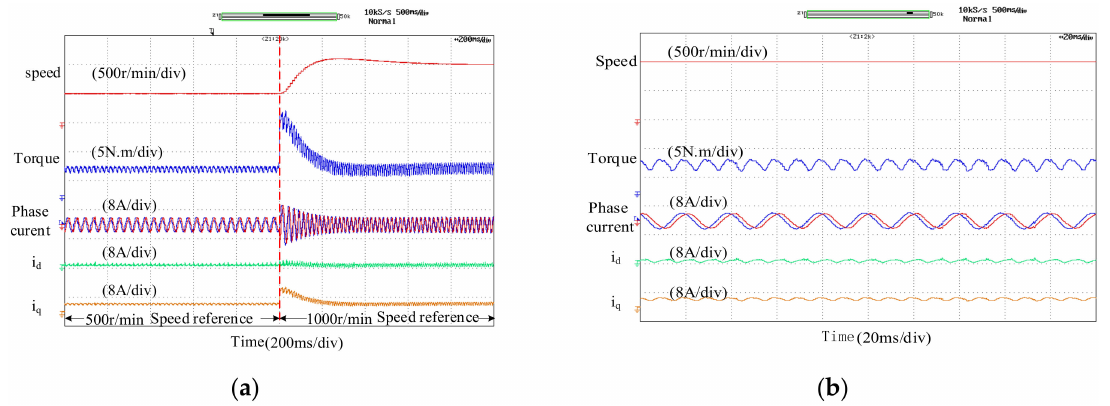
Figure 12. The dynamic performance of the proposed scheme. ( a ) Dynamic performance; ( b ) Enlarged view at 1000